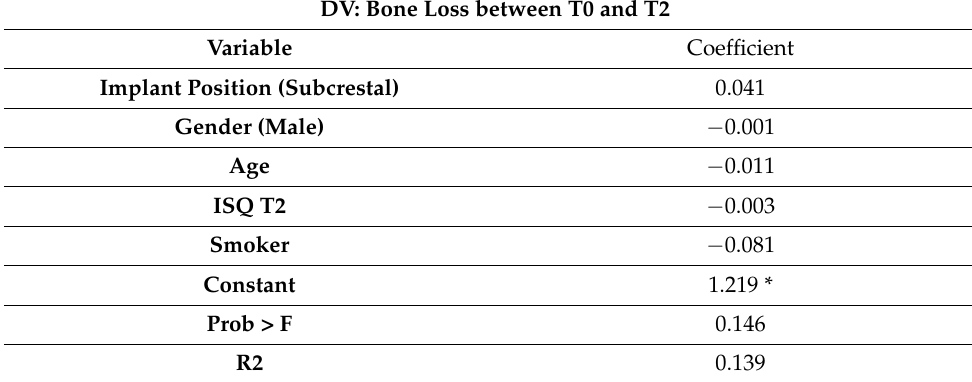
Table 7. Determinants of bone loss between T0 and T2.